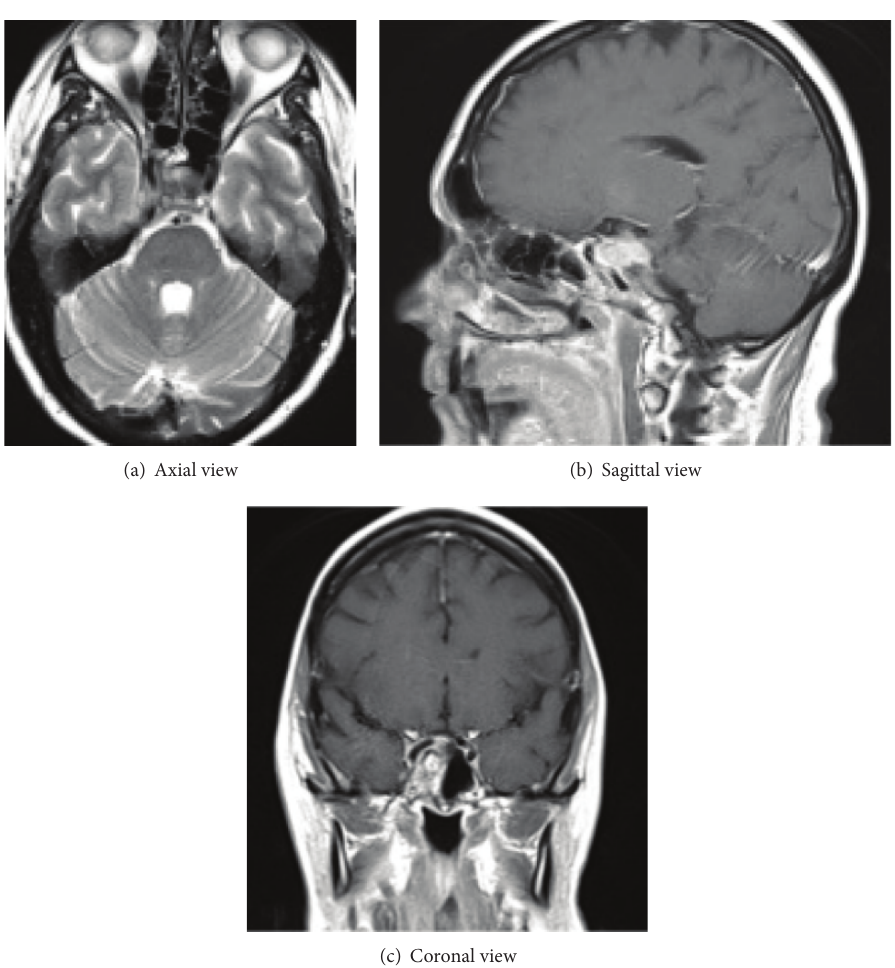
Figure 1: MRI: axial (a), sagittal (b), and coronal (c) views show right cavernous sinus tumor remnant after surgery and